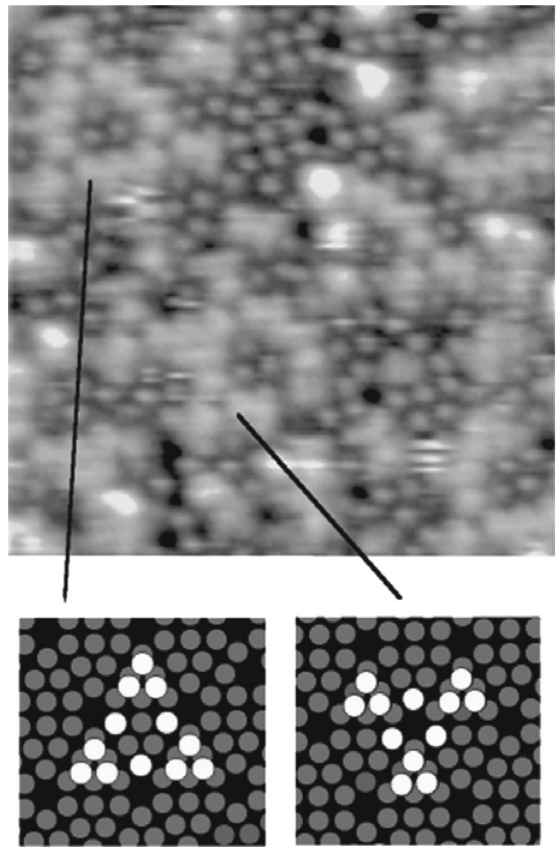
Figure 14. Characteristic structures formed by Fe(CO) as obtained from STM studies. Grey ring: Si(111)7×7 adatoms, White ring: adsorption sites. Reprinted with permission from Ref. [88]. Copyright 1998, American Vacuum